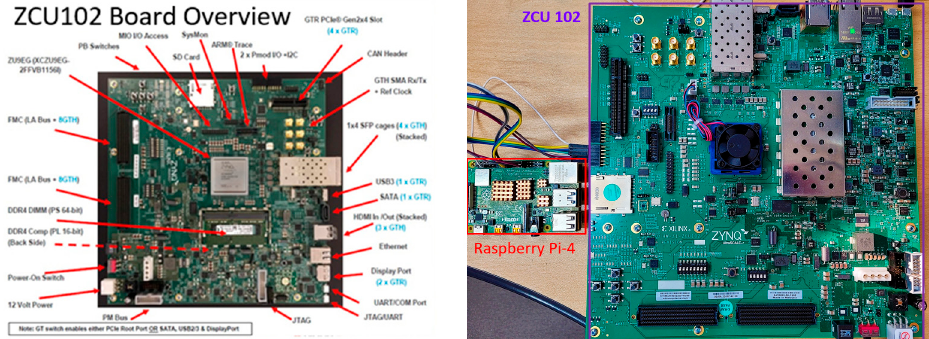
Figure 11. Hardware validation platform (FPGA ZCU102 and Host CPU